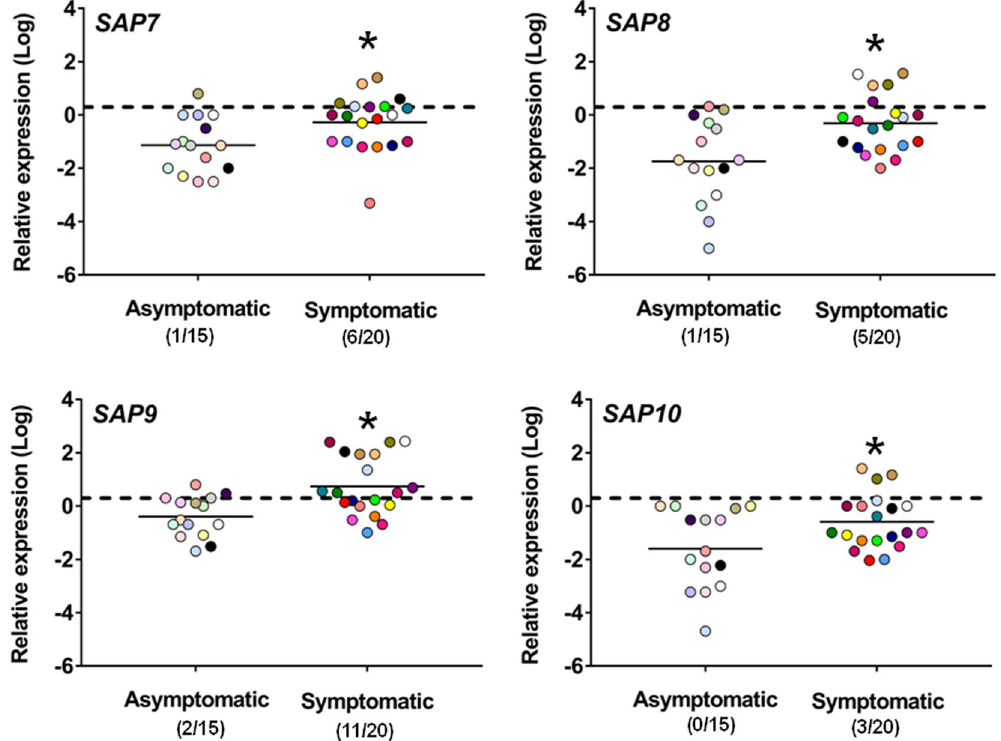
Figure 5. Quantitative analysis of SAP7-10 gene expression. Vaginal samples of asymptomatic (n = 15, identified by dots with different colors) and symptomatic (n = 20, identified by dots with different colors) women were centrifuged at 3000 rpm for 10 min, then cellular fractions were lysed and total RNA was extracted and retro-transcribed in cDNA. The expression levels of SAP7 , SAP8 , SAP9 and SAP10 genes in asymptomatic and symptomatic women were calculated by comparative Ct method (2 − ∆ Ct formula) after normalization with ACT1 gene. The results are from triplicates samples of each subject and the statistical significance was determined with Mann Whitney U test. The dashed line denotes the cutoff at which the overexpression of SAP7-10 genes was defined as > 2 times the value of ACT1 expression and the number of women expressing genes is indicated in the brackets. * p = 0.00961 symptomatic vs asymptomatic women for SAP7 ; * p = 0.00457 symptomatic vs asymptomatic women for SAP8 ; * p = 0.00165 symptomatic vs asymptomatic women for SAP9 ; * p = 0.02851 symptomatic vs asymptomatic women for SAP10